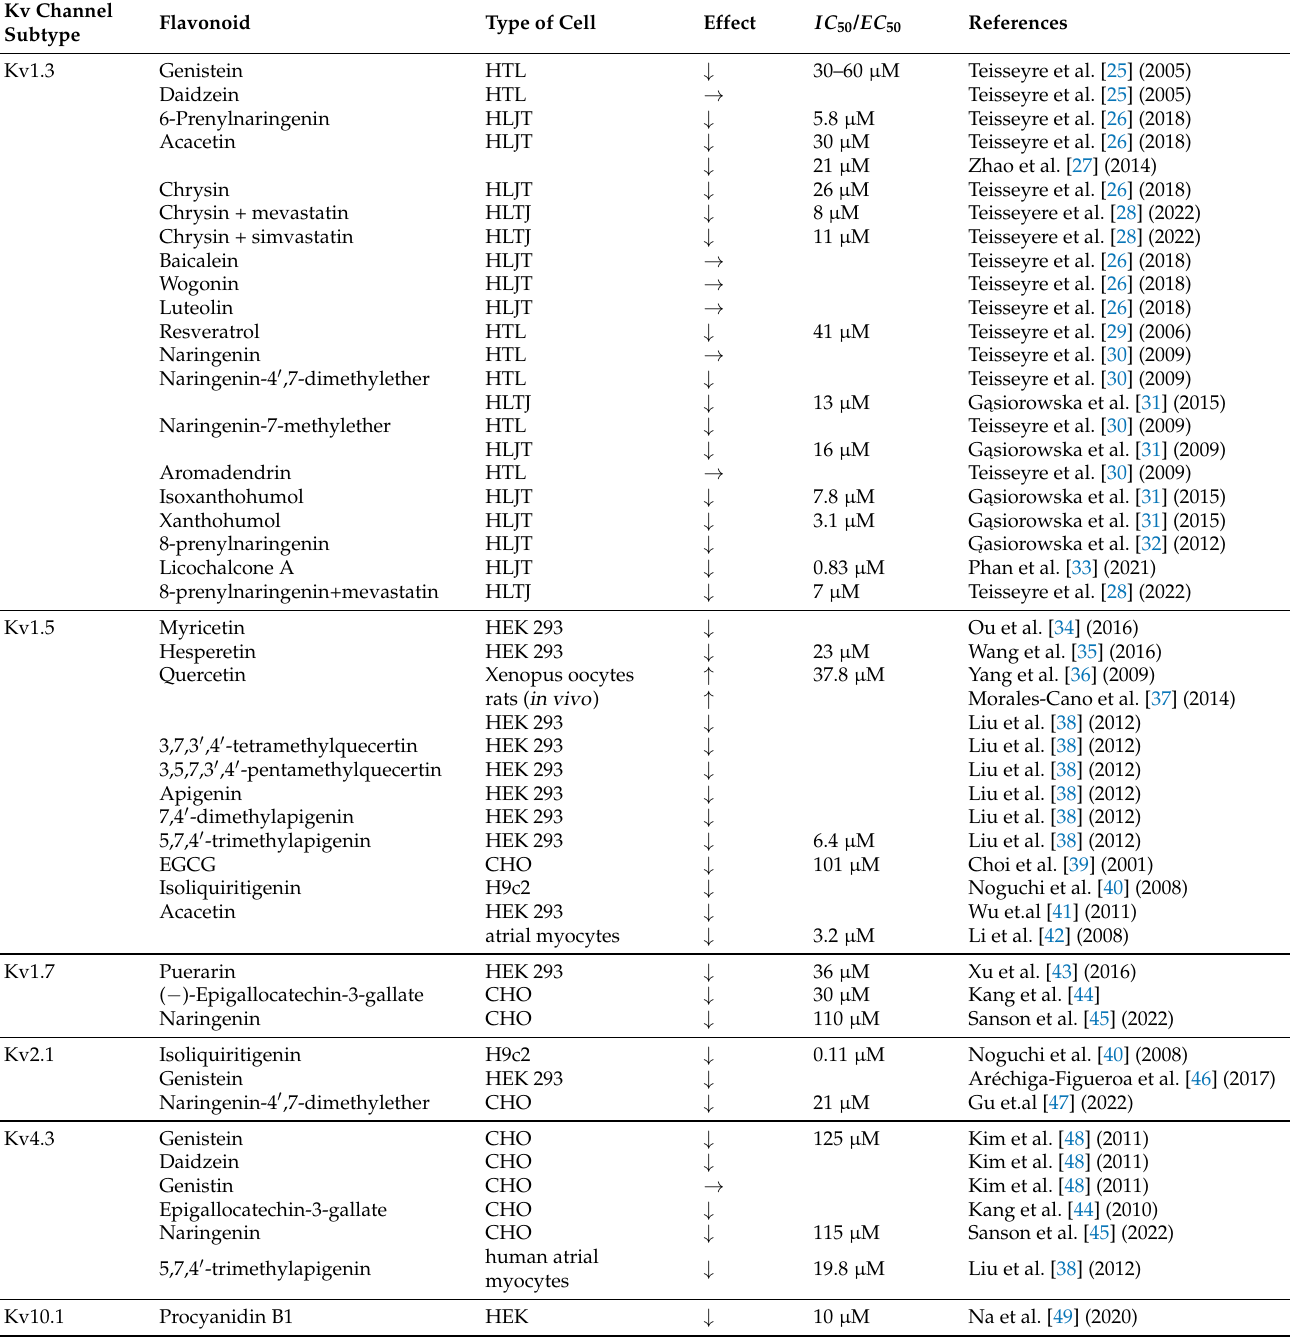
Table 1. Effects of flavonoids on the activity of different subtypes of the Kv channels. HTL stands for human T lymphocytes. HLTJ is human leukemic T cells. EC 50 is defined as the concentration of a flavonoid that gives the half-maximal response. IC 50 is the concentration of a flavonoid concentration at 50% channel inhibition. The arrows symbolize the type of observed effects on the channel activity: ↓ inhibition, ↑ activation, → no effect. As an exception, the table includes resveratrol, which is not a flavonoid, but it was analyzed in the same series of experiments as